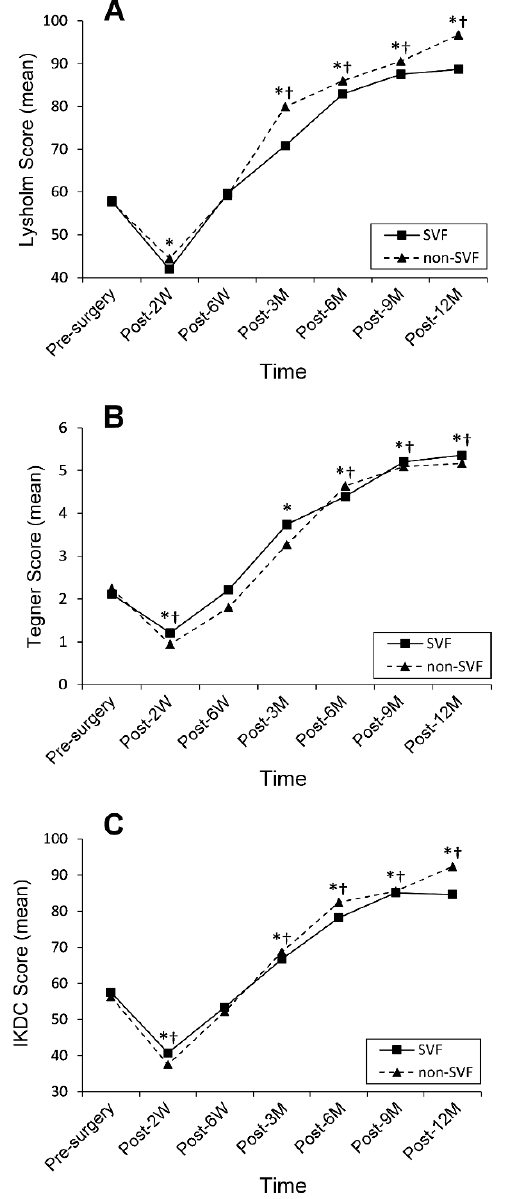
Figure 3. Changes in three types of functional outcome scores in the two study groups during the 12-month follow-up. SVF, adipose stromal vascular fraction; post, post-surgery; W, weeks; M, month; Lysholm, Lysholm knee scoring system; Tegner, Tegner activity scale; IKDC, International Knee Documentation Committee; *, p -value < 0.05 compared with pre-surgery scores in the SVF group; †, p -value < 0.05 compared with pre-surgery scores in the non-SVF group. Data in the graphs are expressed as absolute mean values. Table 2. Correlation matrix of Spearman rank correlation coefficients.